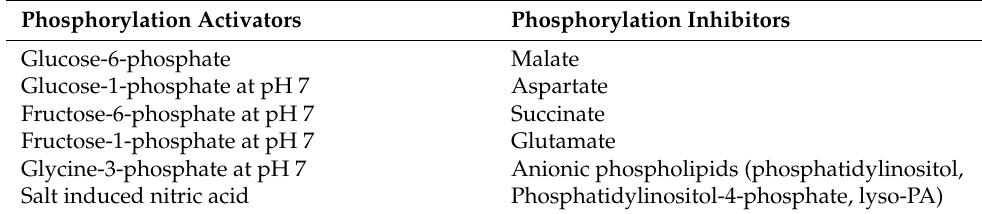
Table 2. Lists of phosphorylation activators and